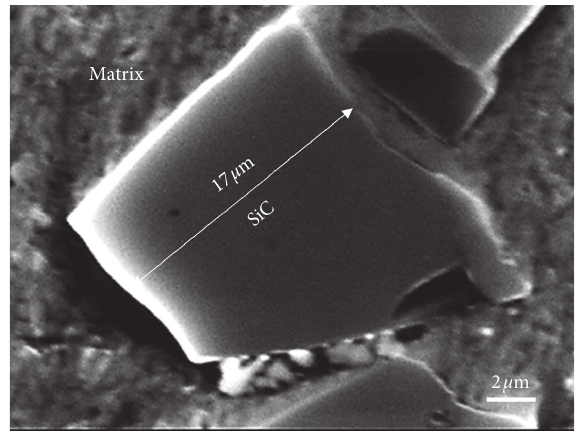
Figure 4: High-magnification secondary electron image of composite C. Note the absence of a gap between the SiC particle and the surrounding matrix.